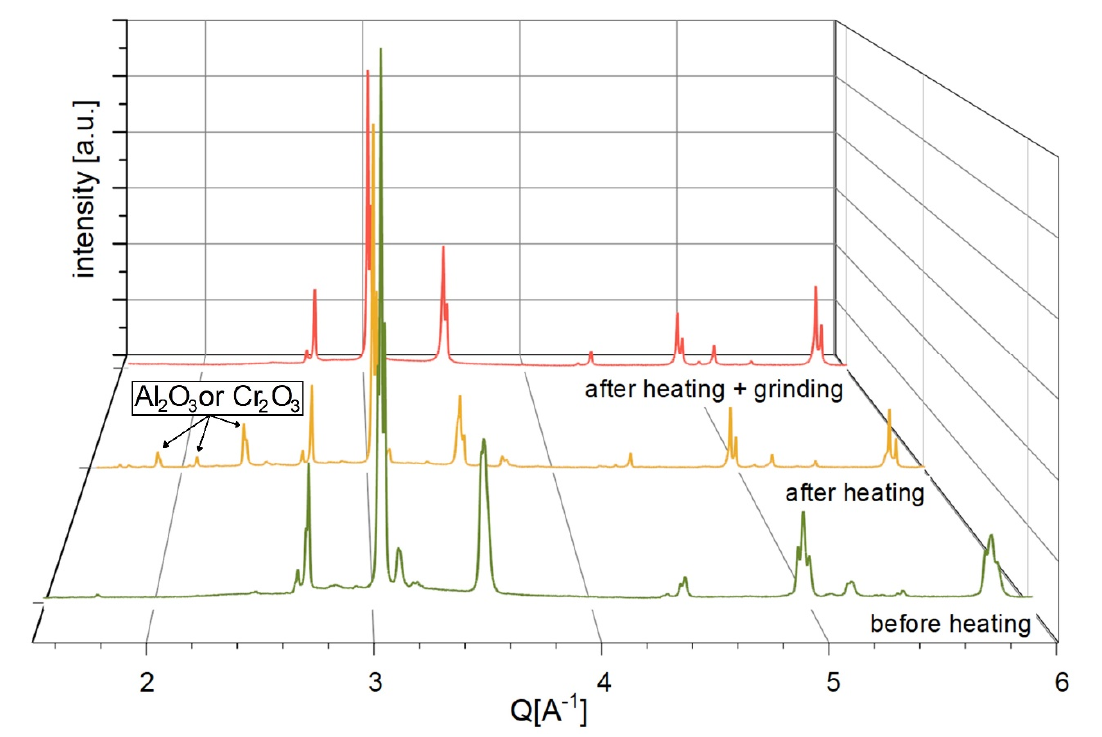
Figure 11. Diffraction patterns were taken at room temperature after different steps of the measuring program: (1) initial condition (before heating), (2) the condition after in-situ high-temperature XRD (after heating), (3) the condition after in-situ high-temperature XRD, surface grinding, and polishing (after heating + grinding).